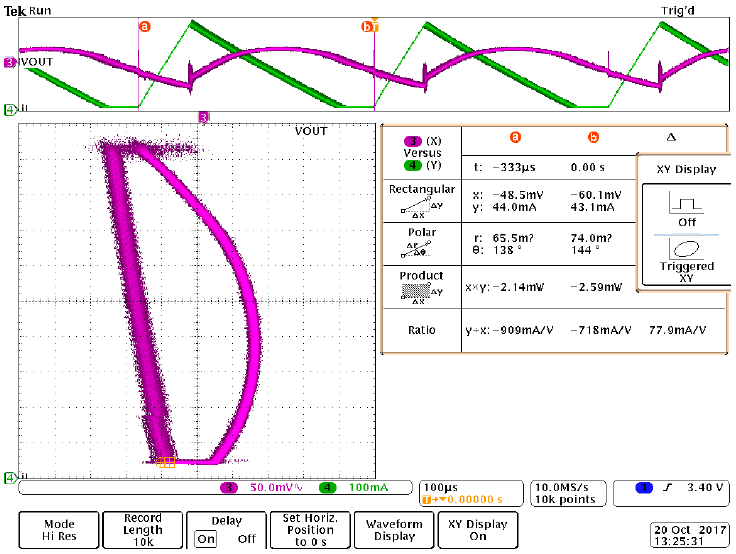
Figure 11. Phase portrait for k = 1.08, confirming stable operation.